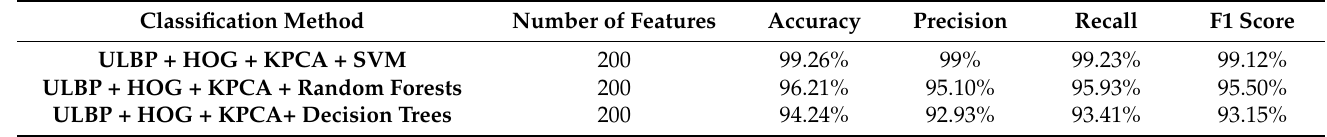
Table 7. Accuracy, Precision, Recall, and F1-score feature fusion following KPCA